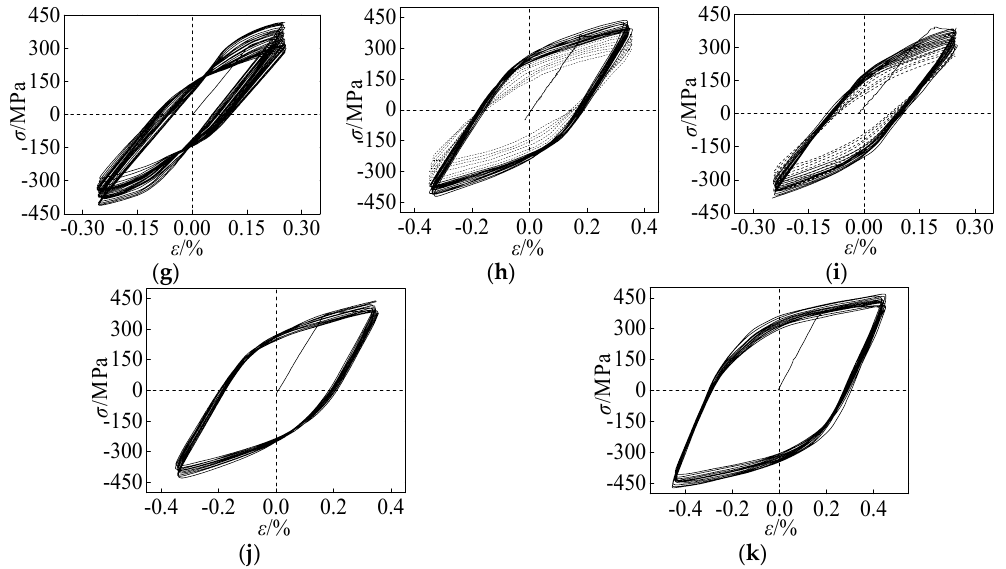
Figure 7. Stress-strain ( σ - ε ) hysteresis curve of the steel (base metal) specimen.( a ) SA1 (1) ε max = 0.25%; ( b ) SA1 (2) ε max = 0.35%; ( c ) SA1 (3) ε max = 0.45%; ( d ) SA2 (1) ε max = 0.25%; ( e ) SA2 (2) ε max = 0.35%; ( f ) SA2 (3) ε max = 0.45%; ( g ) SB1 (1) ε max = 0.25%; ( h ) SB1 (2) ε max = 0.35%; ( i ) SB2 (1) ε max = 0.25%; ( j ) SB2 (2) ε max = 0.35%; ( k ) SB2 (3) ε max = 0.45%.